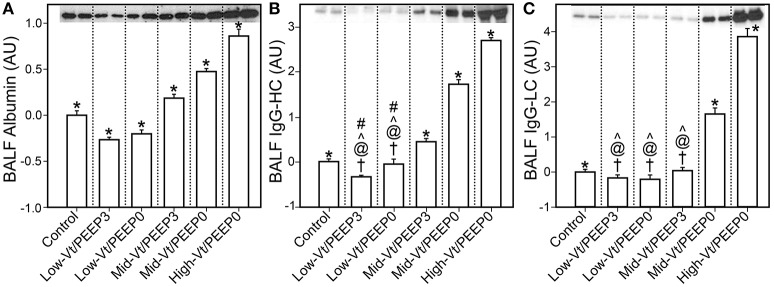
Blood-borne molecules in the bronchoalveolar lavage fluid (BALF) normalized to the control group: (A) serum albumin, (B) immunoglobulin G heavy chain (IgG-HC), (C) and immunoglobulin G light chain (IgG-LC). Error bars show the standard deviation. Significant difference from all other groups (*), from control (†), Mid-Vt/PEEP3 (#), Mid-Vt/PEEP0 (@), and High-Vt/PEEP0 (∧). Error bars show standard deviation.